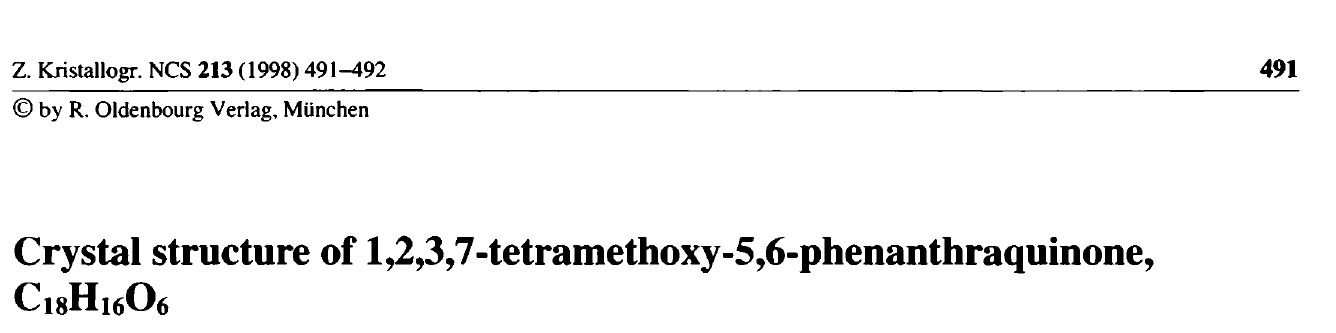
Fig. 1. Molecule plot.